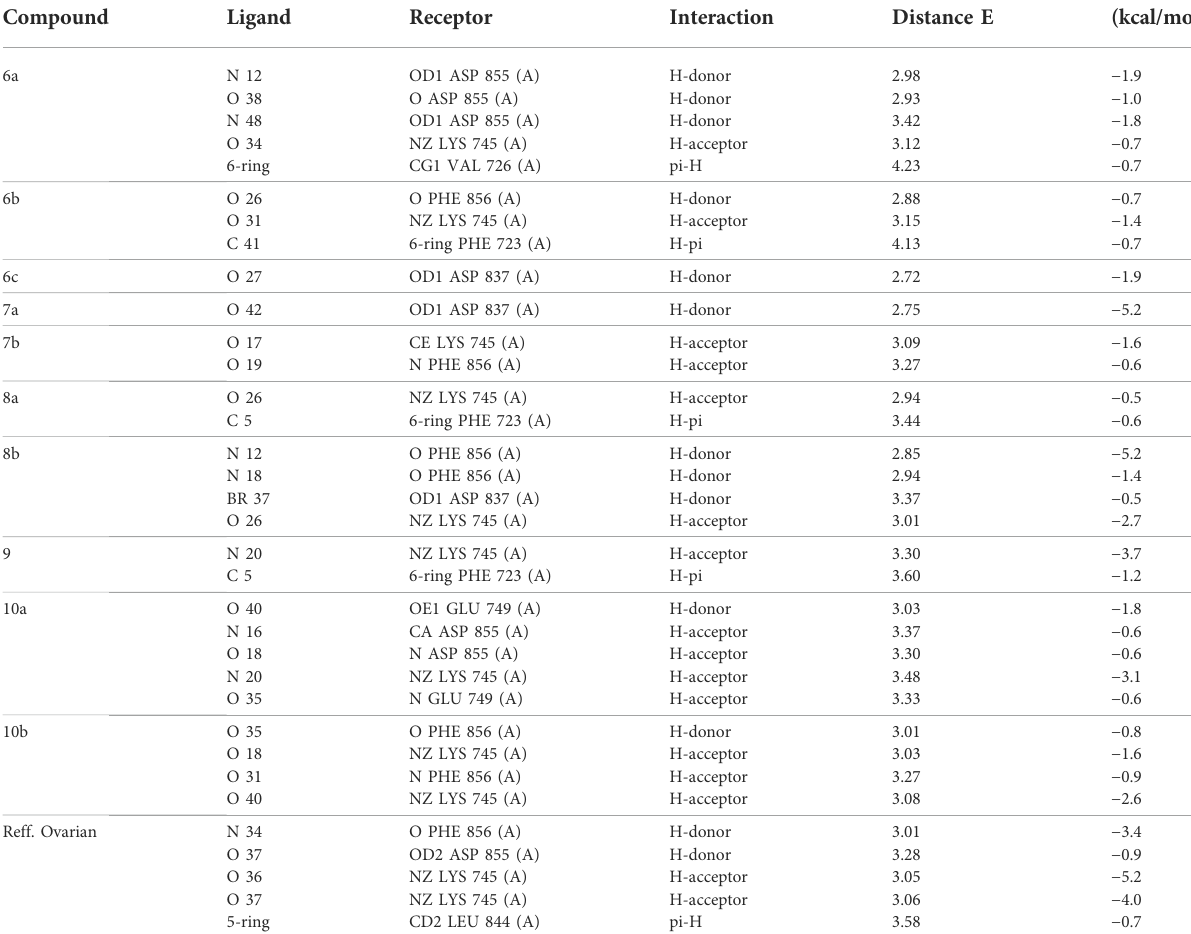
TABLE 4 Docking interaction of all compounds with 3W2S “ ovarian cancer protein.